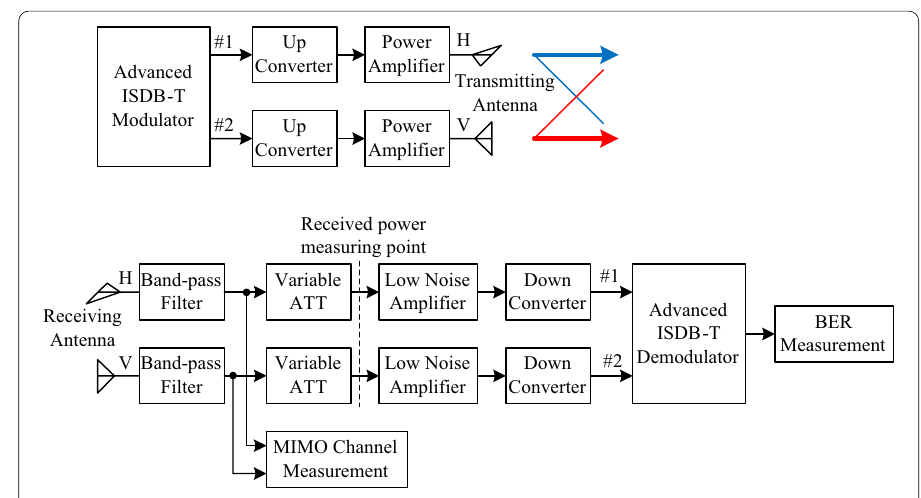
Fig. 7 Block diagram of transmission and reception equipment for field